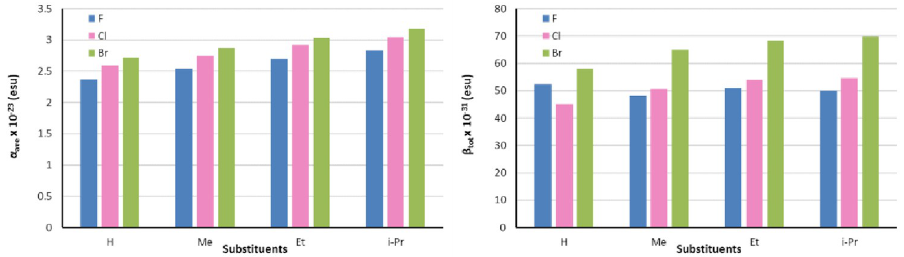
Fig 15. The α ave x 10 − 23 (esu) and β tot x 10 − 31 (esu) at the B3LYP/6-311+G(d,p) level for fuberidazole derivatives (5a-5p).